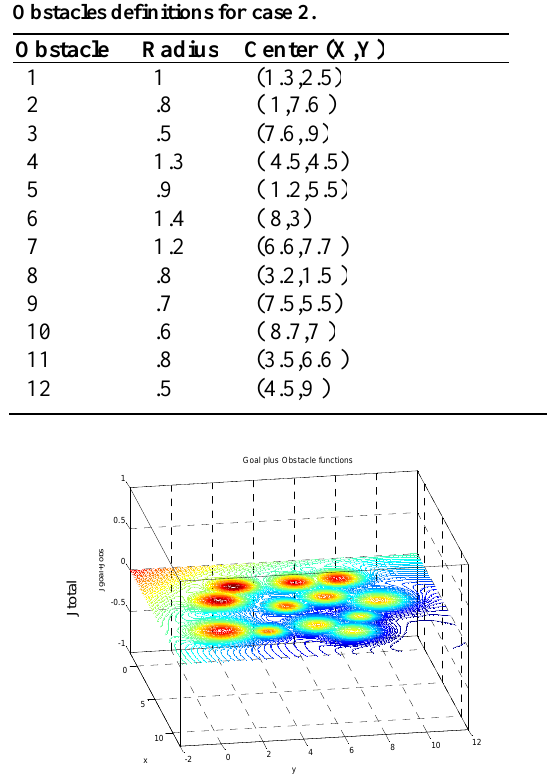
Fig. 12: shortest time path for case 2 (2nd test).